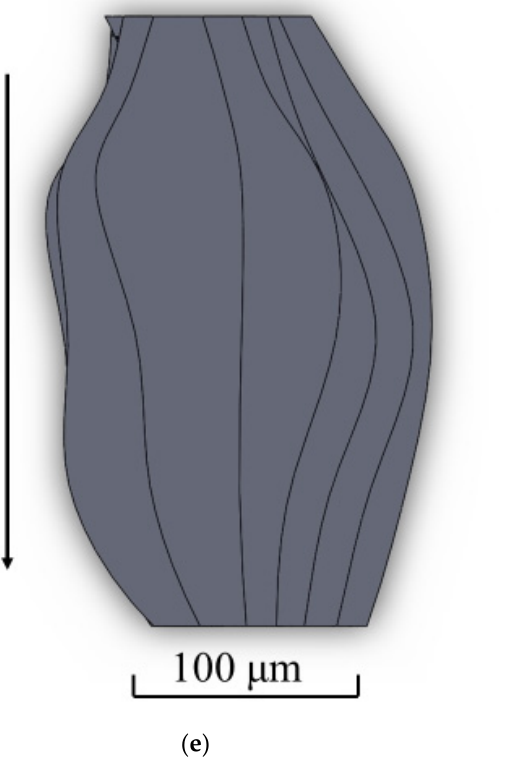
Figure 8. Side view ( a ), front view ( c ) and top view ( e ) of the grain 3D model before screw rolling and side view ( b ), front view ( d ) and top view ( f ) of grain 3D model after screw rolling (arrows identify the rolling direction).